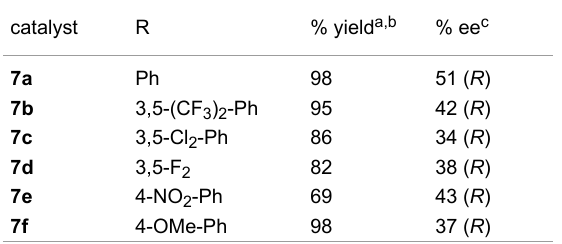
Table 3: Influence of phenyl substituents on yields a and selectivity (catalysts 7a – f , cf. Scheme 1). catalyst R % yield